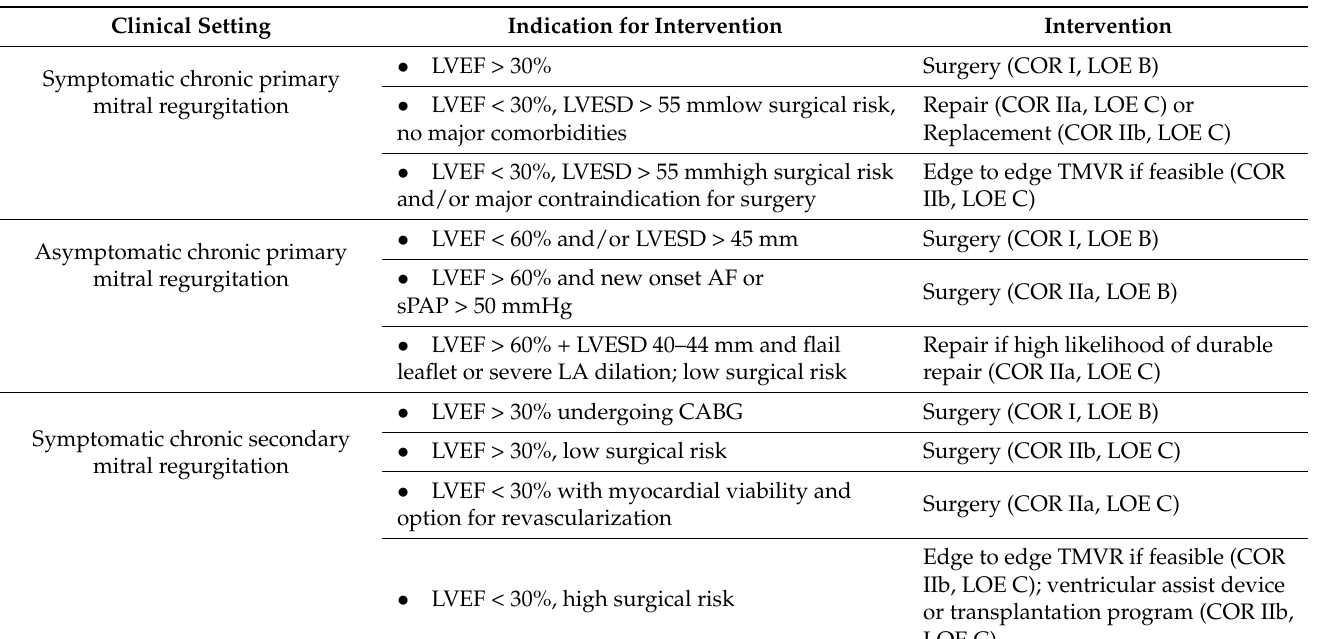
Table 3. Current indications for MR